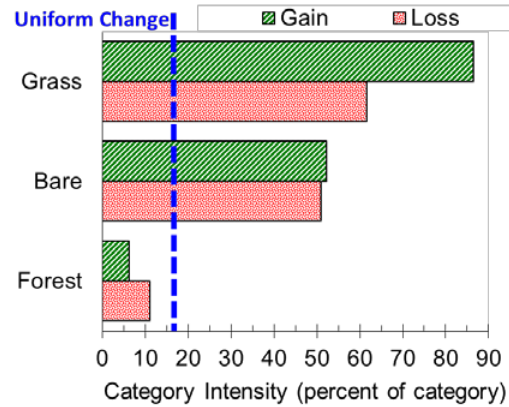
Figure 4. Intensity of gains and losses by